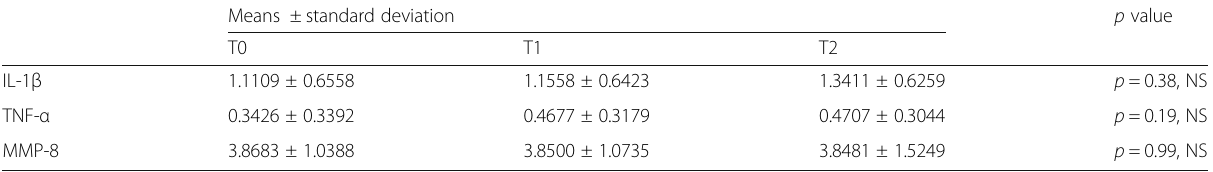
Table 3 Cytokine levels (pg/mL) in the gingival crevicular fluid (means ± standard deviation); log expression, at T0, T1, and T2; and baseline, 6 and 12